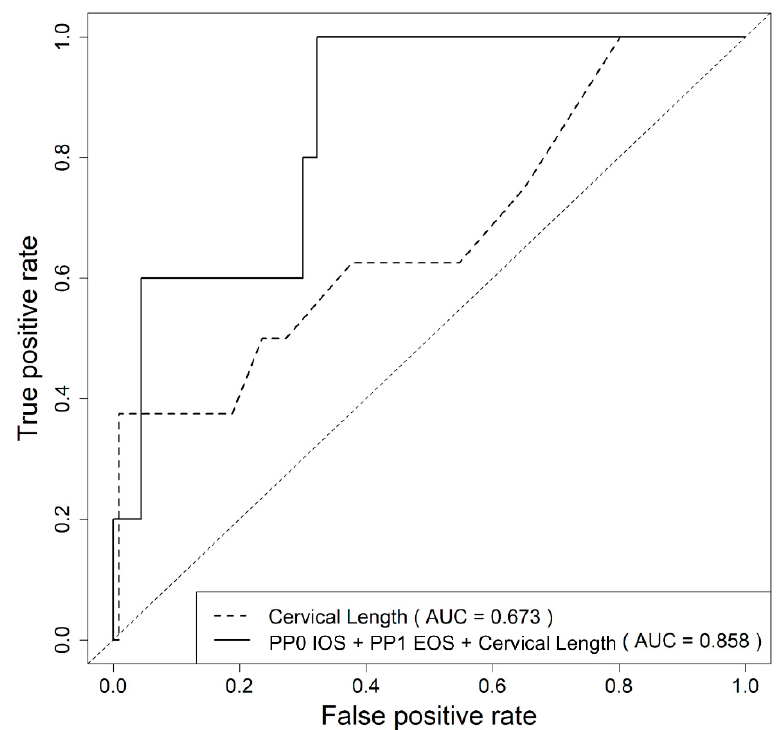
Figure 4. Receiver operating characteristic curve for the prediction of spontaneous preterm